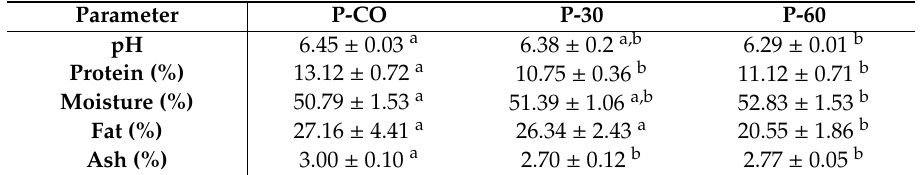
Table 1. pH and chemical composition of all sets of pasteurized p â t é samples; (P-CO: control sample; P-30 and P-60: samples with 30% and 60% of pork fat replacement, respectively).